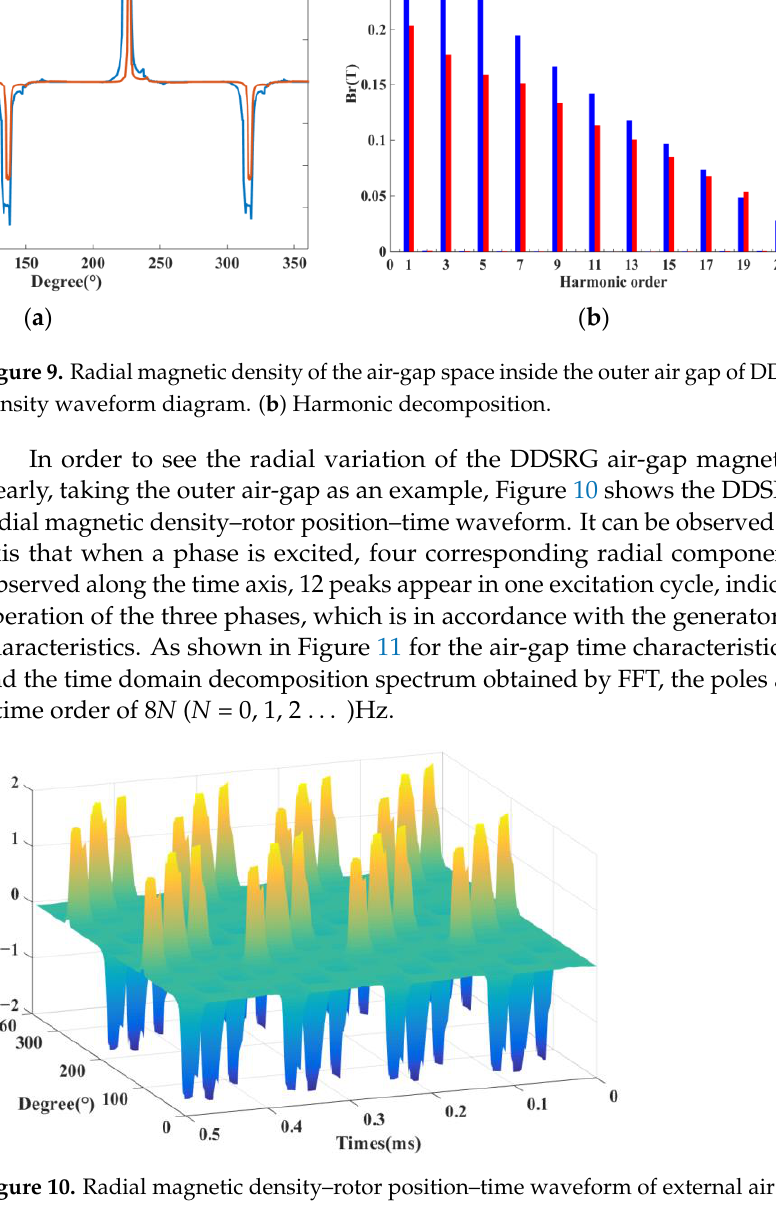
( b ) Figure 11. Radial magnetic density of air-gap time inside and outside the DDSRG. ( a ) Magnetic density. ( b ) Harmonic decomposition. Figure 12 shows the ERF waveform, and compared with the spatial distribution of radial magnetic density, it can be found that the ERF has a larger amplitude at the larger radial magnetic density, which is consistent with the theoretical derivation. According to the enlarged plot, it can be found that the ERF distribution is not uniform mainly in the front of the stator teeth, while the amplitude at the back is small. In order to observe the ERF time and space distribution more easily, Figure 13 shows the DDSRG radial elec- tromagnetic force – rotor position – time waveform, and it can be observed along the time axis that the ERF is alternately distributed with the rotor position change during an op- erating cycle. When each phase winding is operated, there are four peaks corresponding to it.